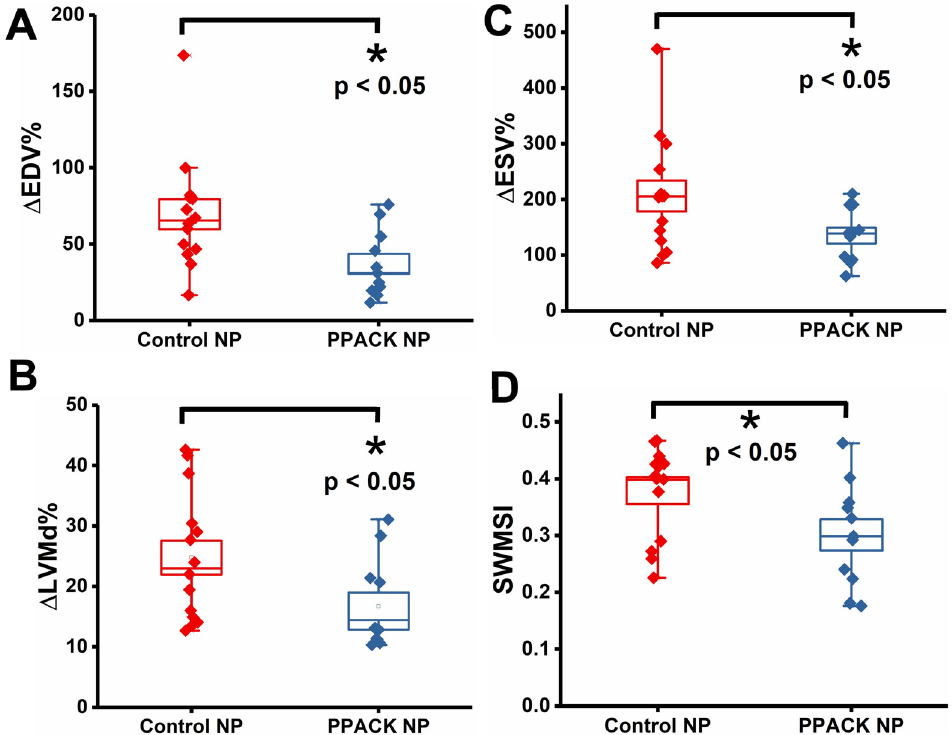
Figure 2. PPACK PFC NP treatment preserved ventricular structure and function. ( A ) Percentage change of End-Diastolic Volumes ( ∆ EDV%). ( B ) Percentage change of End-Systolic Volumes ( ∆ ESV%). ( C ) Percentage change of Left ventricular mechanical dyssynchrony ( ∆ LVMD%). ( D ) segmental wall motion score index (SWMSI). ( n = 11 PPACK NP and n = 14 control NP. Mean ± SEM, *: p < 0.05).